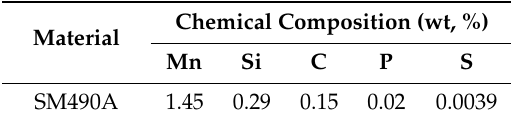
Table 3. Chemical composition of type 490A hot-rolled steel.